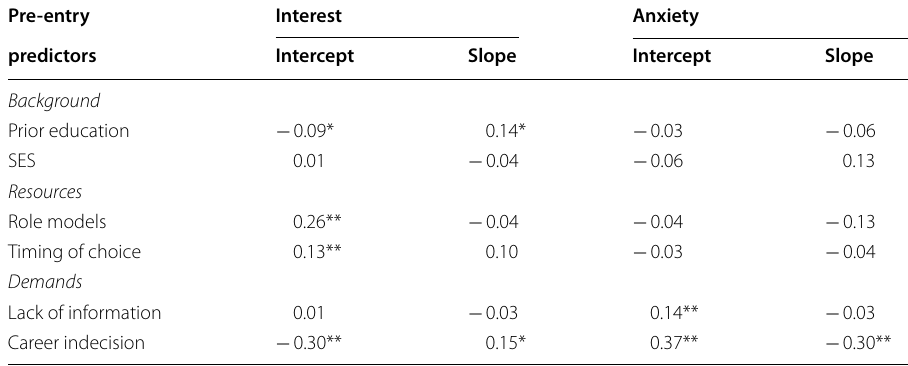
Table 8 Pre-entry predictors of between-apprentice variance (standardised)